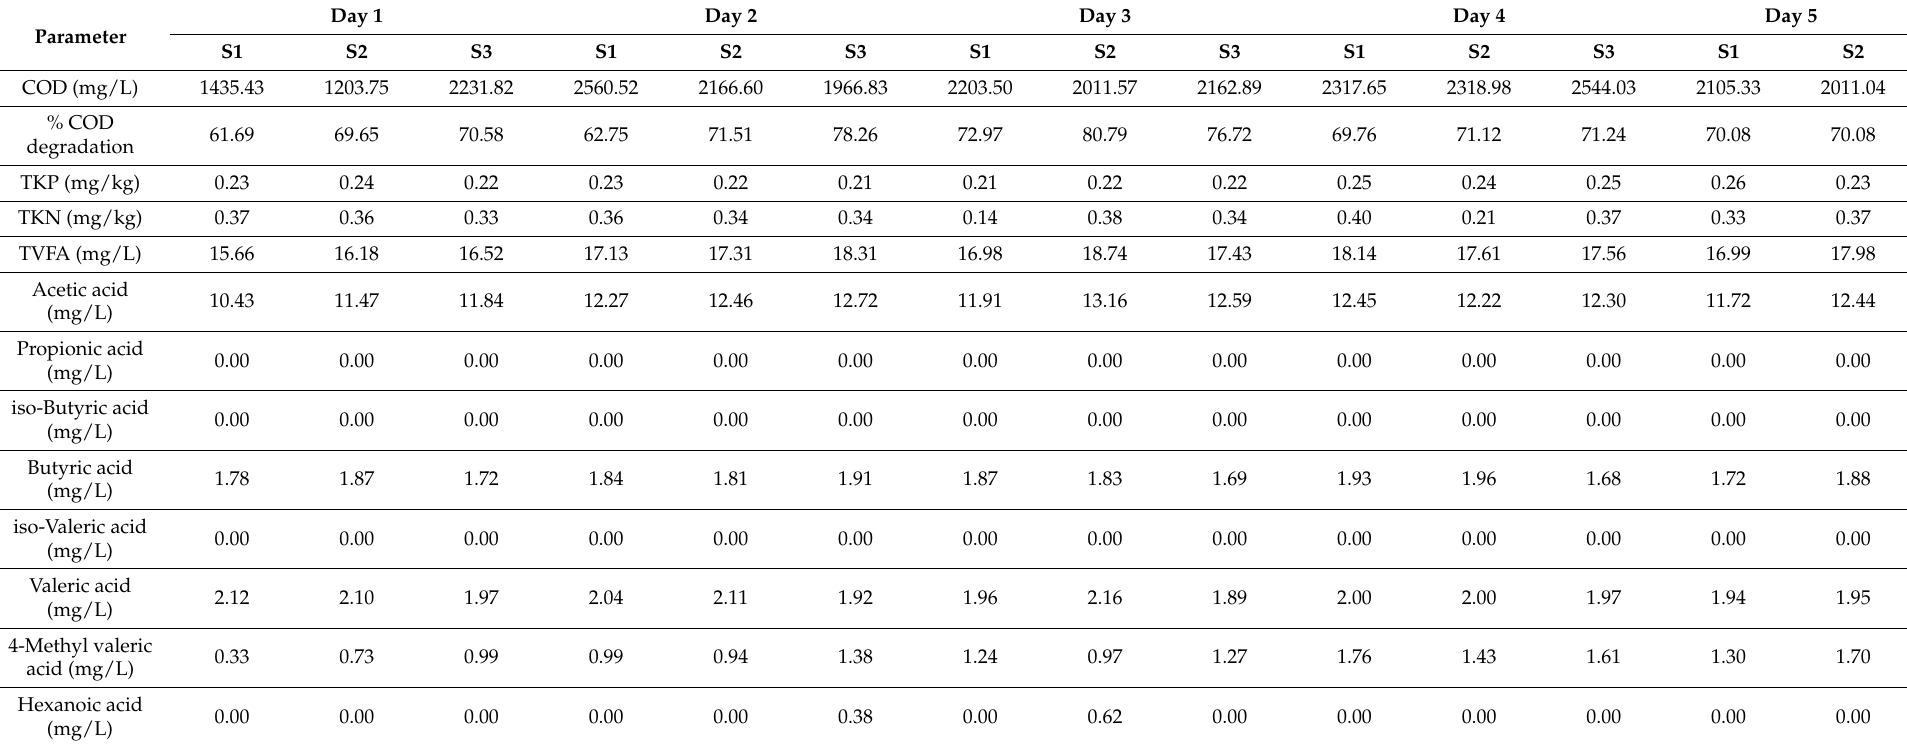
Table 2. Temporal variation in the chemical composition of the digestates obtained during the anaerobic digestion of rendering plant wastewaters in batch experiments at 37 ◦